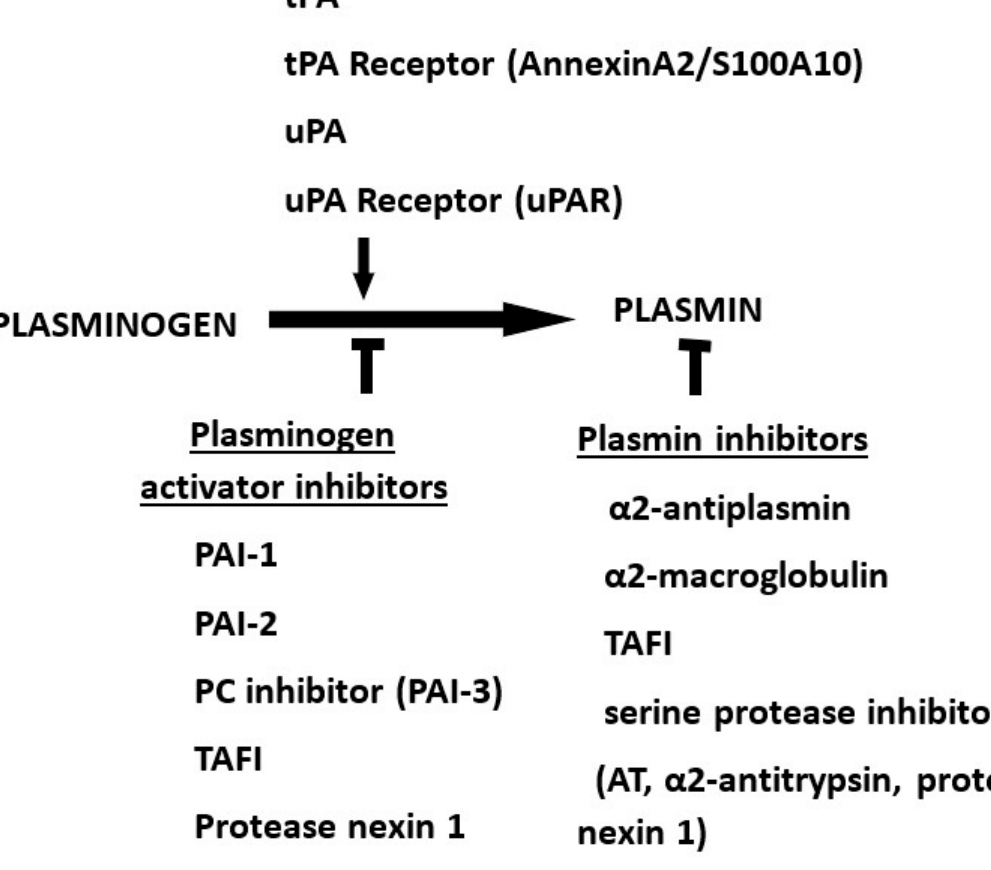
Table 1. Physiological functions of the fibrinolytic system.